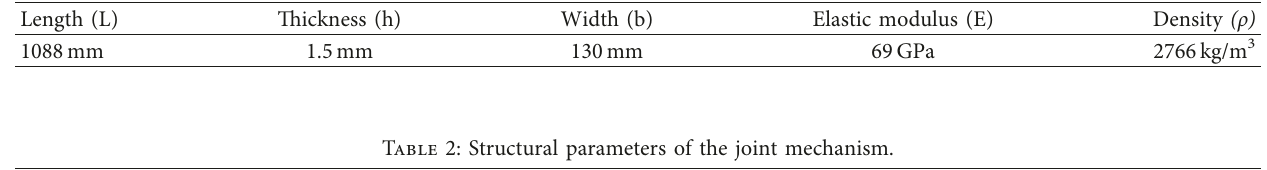
Table 1: Mechanism parameters of the rotational flexible appendage.